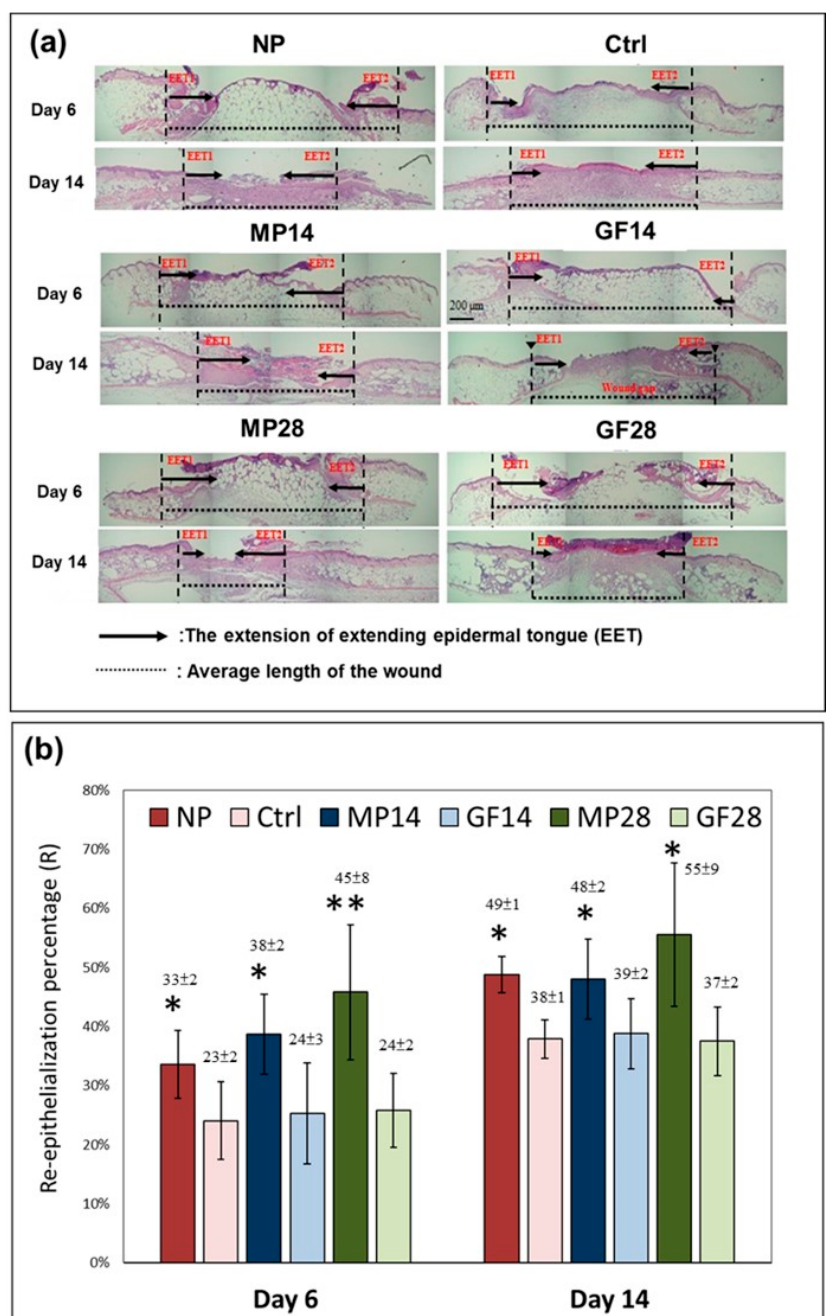
Figure 3. MP treatment promoted wound bed re-epithelialization of the NP, control, MP14, GF14, MP28, and GF28 groups on days 6 and 14 (Study 2). ( a ) Wound tissue sections stained with H&E with representative images. The distance between the two vertical dashed lines represents the average length of the wound (or wound gap), and, in between, the arrows denote the extension of the EET from the left (EET1) or right (EET2). ( b ) The quantitative data of the re-epithelialization percentage (R) in the wound gap. The values presented are the means ± SDs ( n = 6), with * p < 0.05 and ** p < 0.01 compared with the control